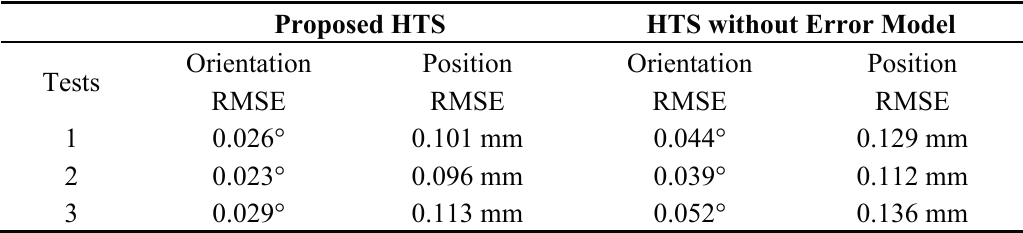
Figure 9. Bias of the inertial sensors. ( a ) Accelerometer; ( b ) Gyroscope; ( c ) Magnetometer. Table 1. Orientation and position tracking results with and without the error model. Proposed HTS HTS without Error Model